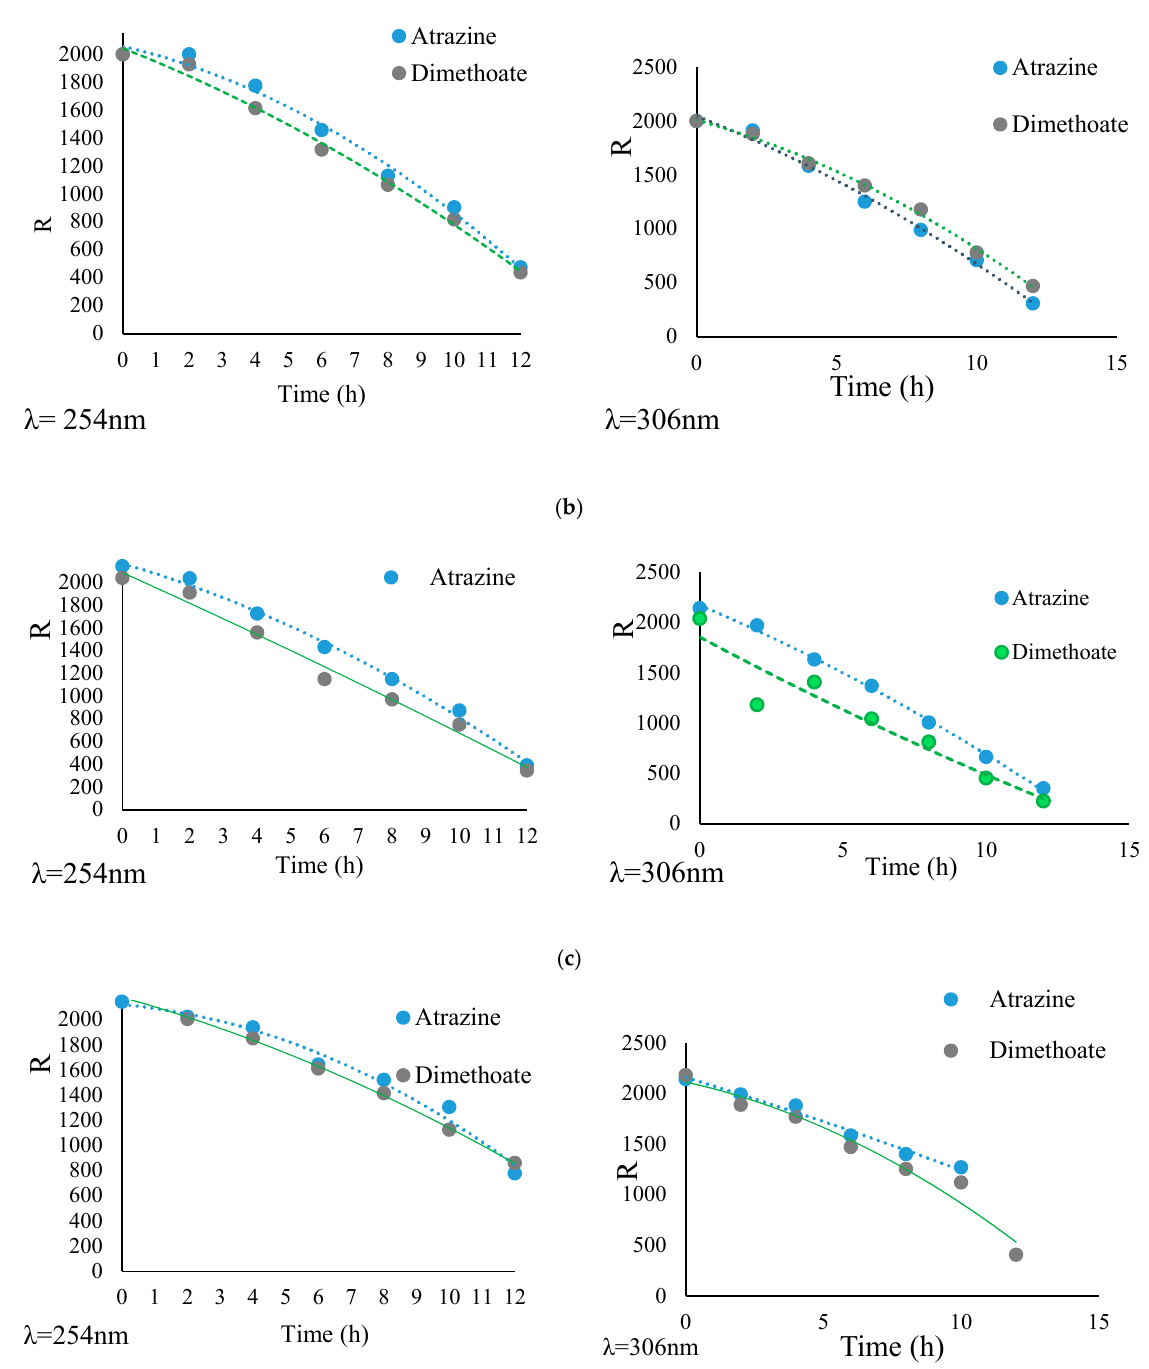
Figure 1. Concentration of pesticides (R = ppb) as a function of exposure time of irradiation for photolysis process of pesticides (non-catalytic process); ( a ). AS, ( b ). WW, and ( c ). Ag.W.